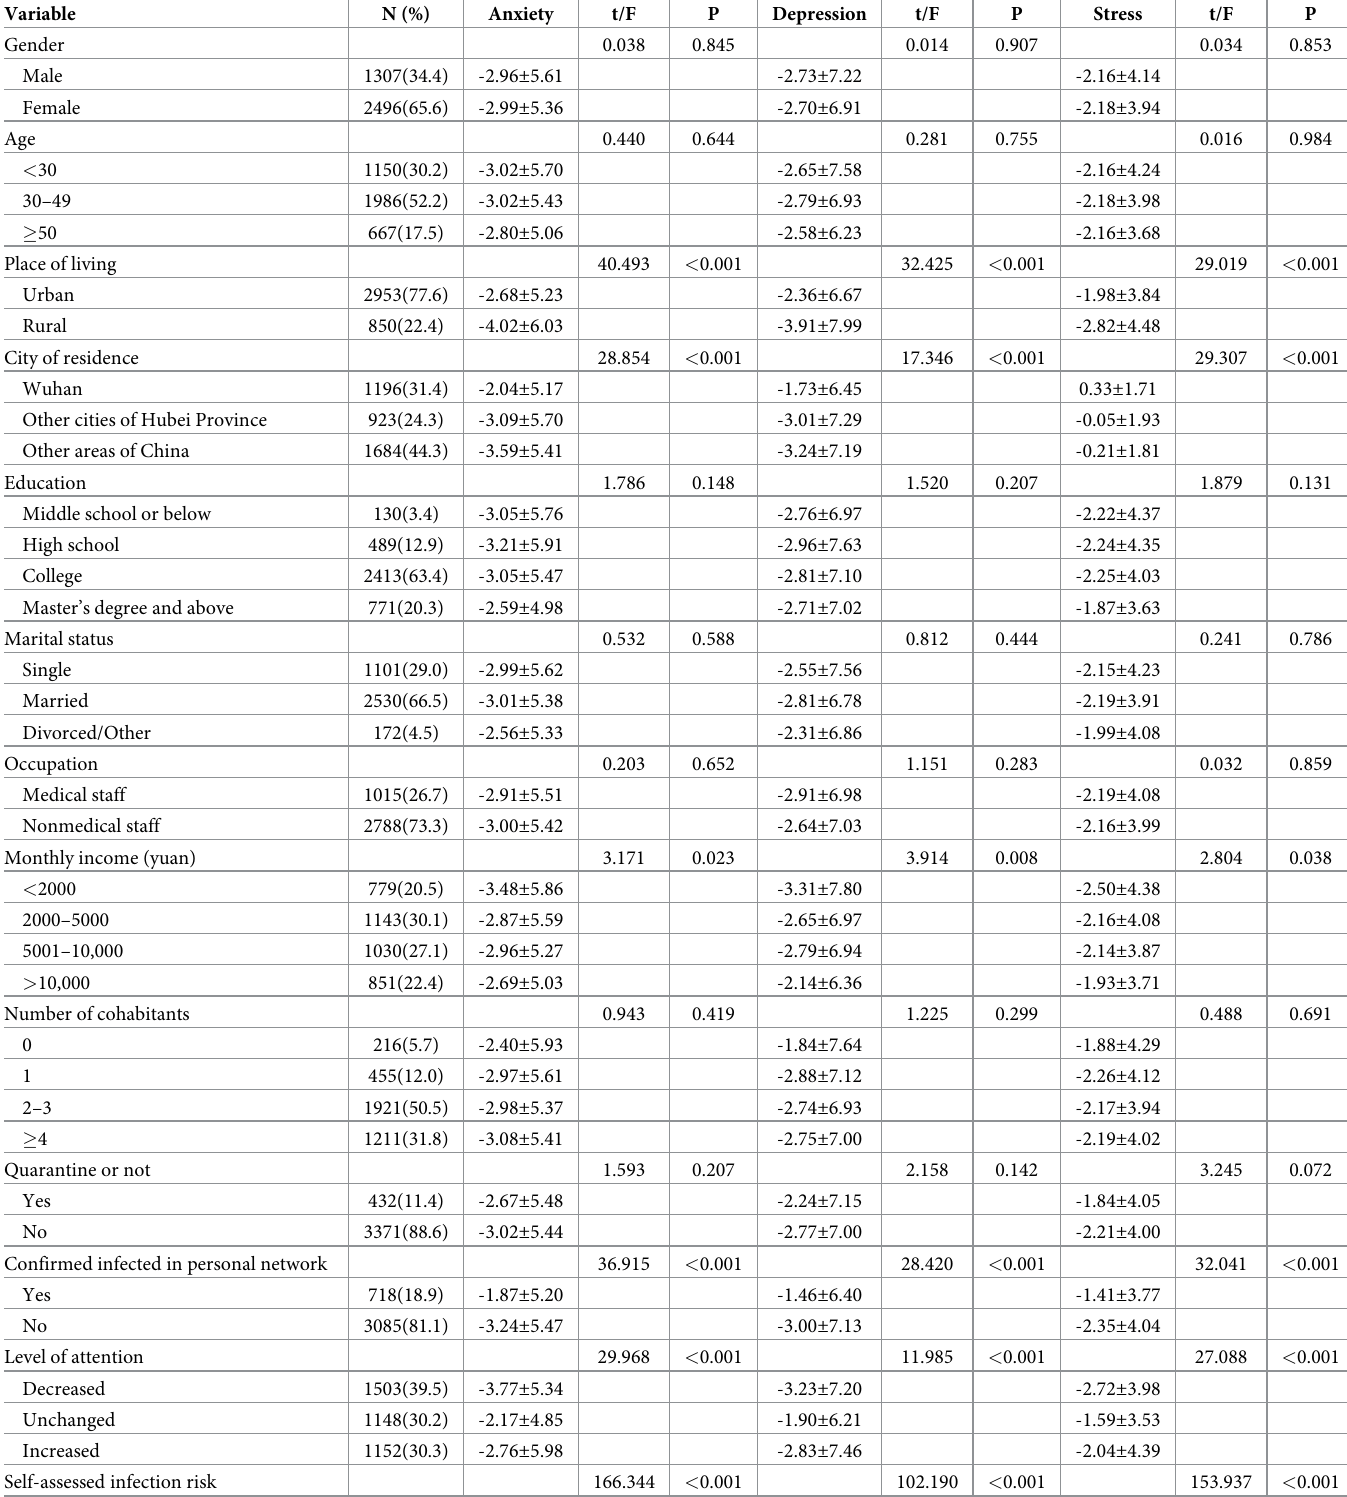
Table 1. Factors affecting anxiety, depression, and stress in the survey (n = 3803; X ± S;